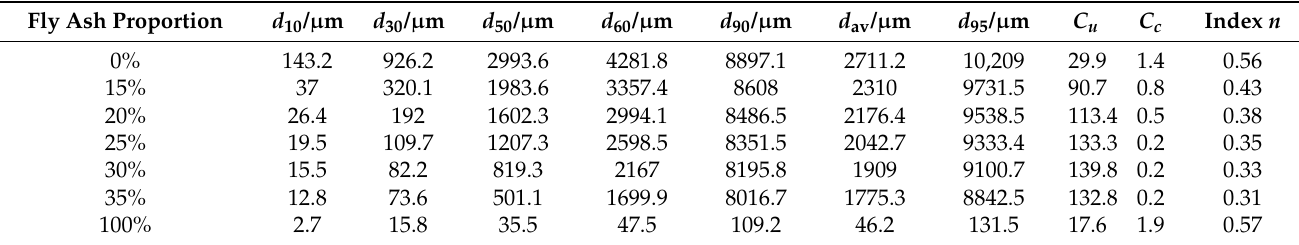
Figure 1. PSD, appearance, and XRD patterns of waste rock and fly ash. Table 2. Featured particle parameters of the mixed